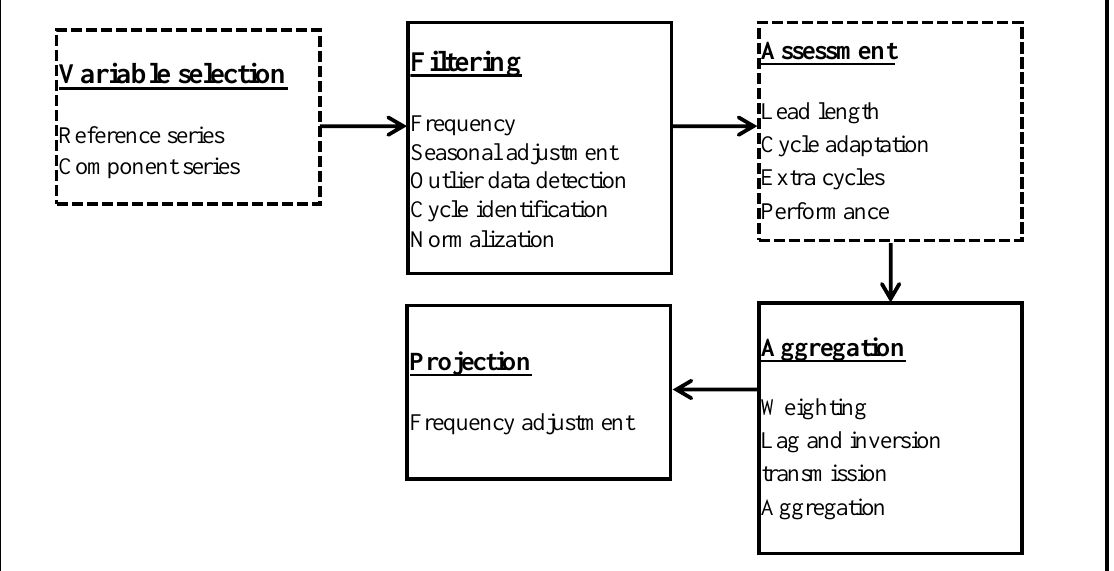
represents the proposed procedure.